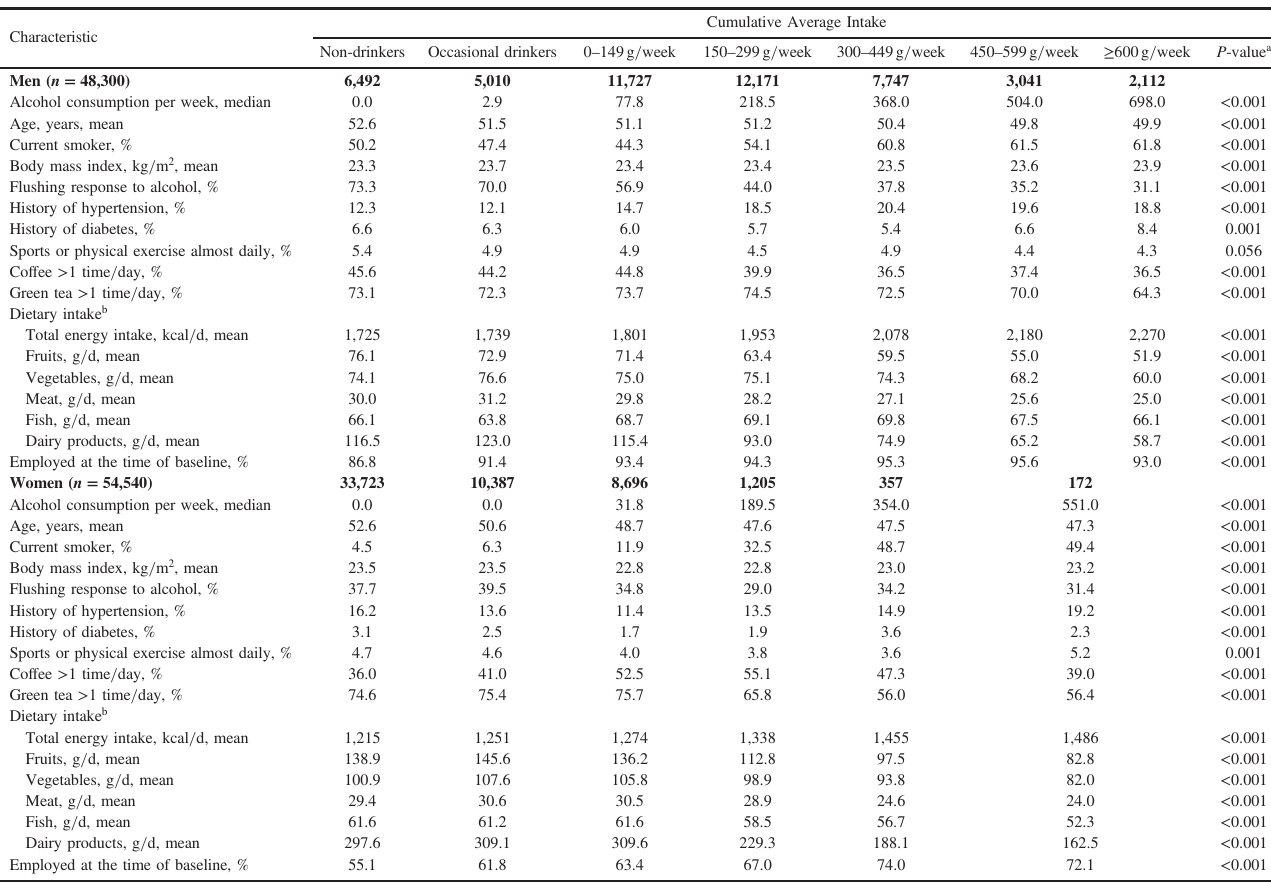
Cumulative Average Intake